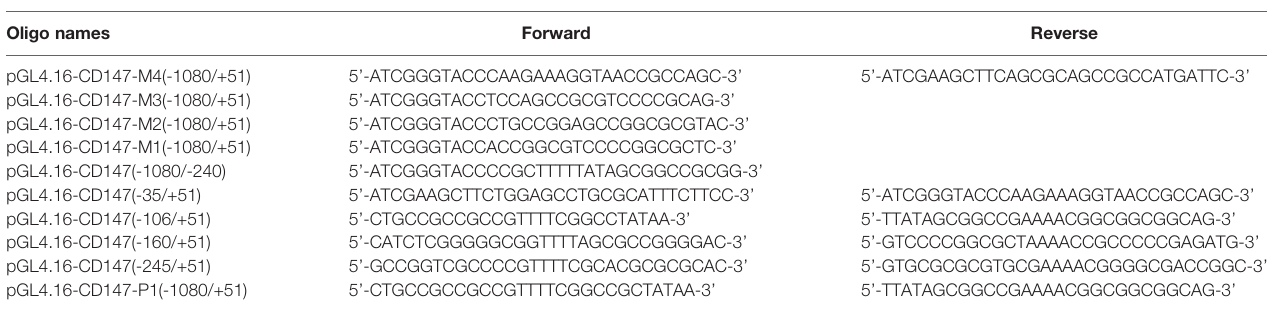
TABLE 1 | Oligonucleotide sequence of polymerase chain reaction (PCR)